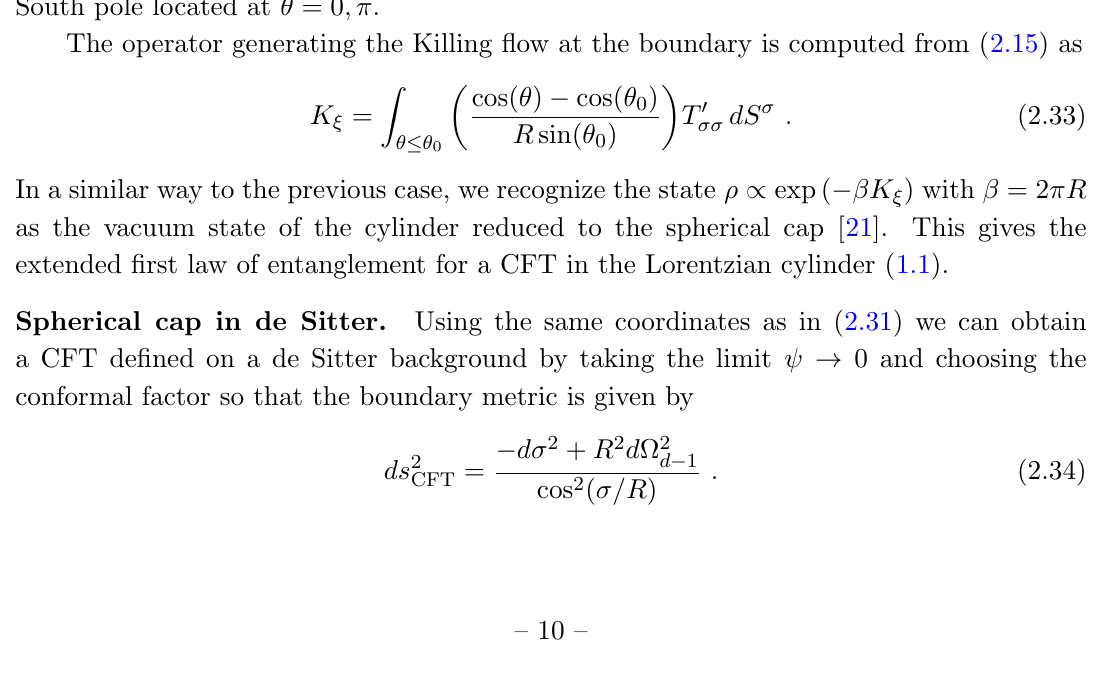
= (cid:0) d(cid:27) 2 + R 2 d (cid:10) 2 . The CFT d (cid:0) 1